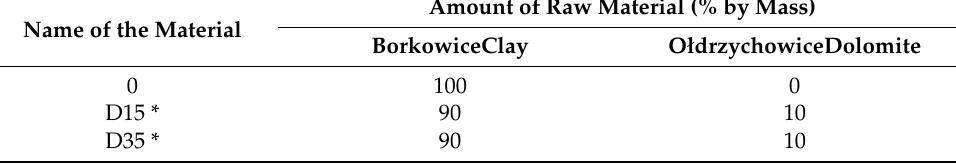
Table 1. Composition of ceramic masses.